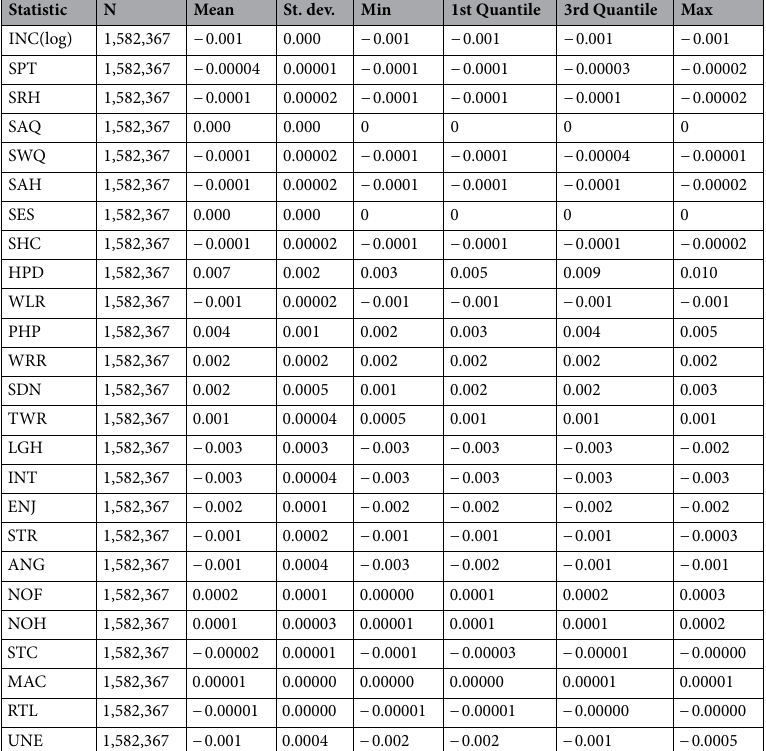
Table 1. The cumulative effects of age on each variable affecting life